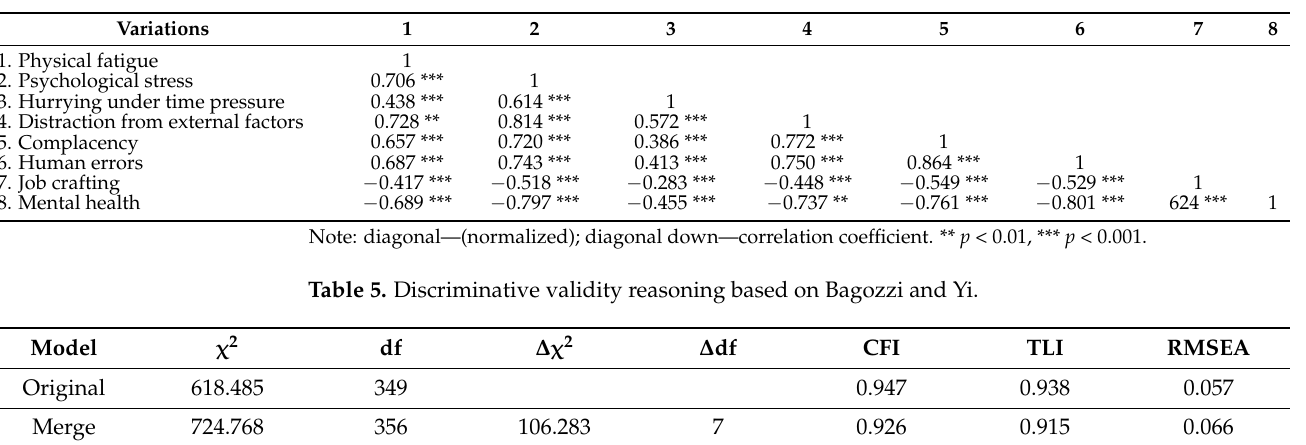
Table 4. Verification of Relationship between each Potential Variables.